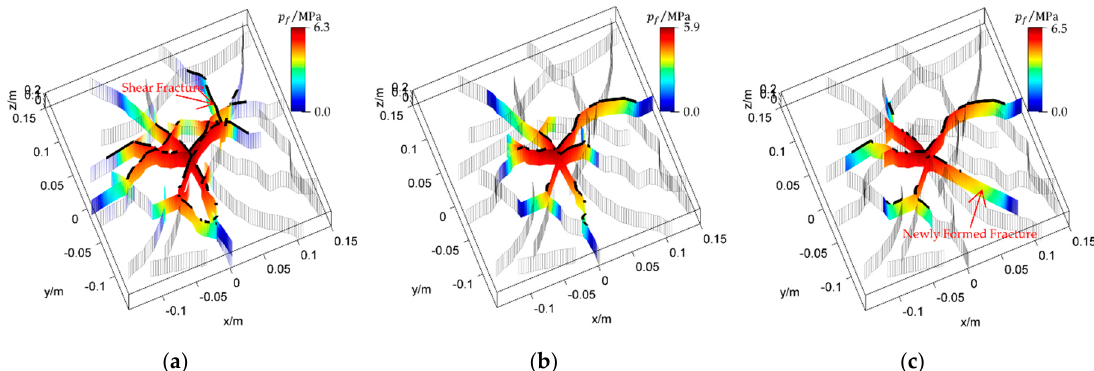
Figure 3. Fracture network configurations under different cohesions of pre-existing fracture. ( a ) C = 0 MPa; ( b ) C = 5 MPa; ( c ) C = 10 MPa. Here, C is the cohesion of pre-existing fractures. In these figures, the fluid pressure ( p f ) in the fluid-affected fractures is represented by color. The fractures that are not affected by fluid are represented by the gray meshes. The shear fractures are marked by the bold curves at the top. The stress difference σ y − σ x is equal to 0 MPa in these